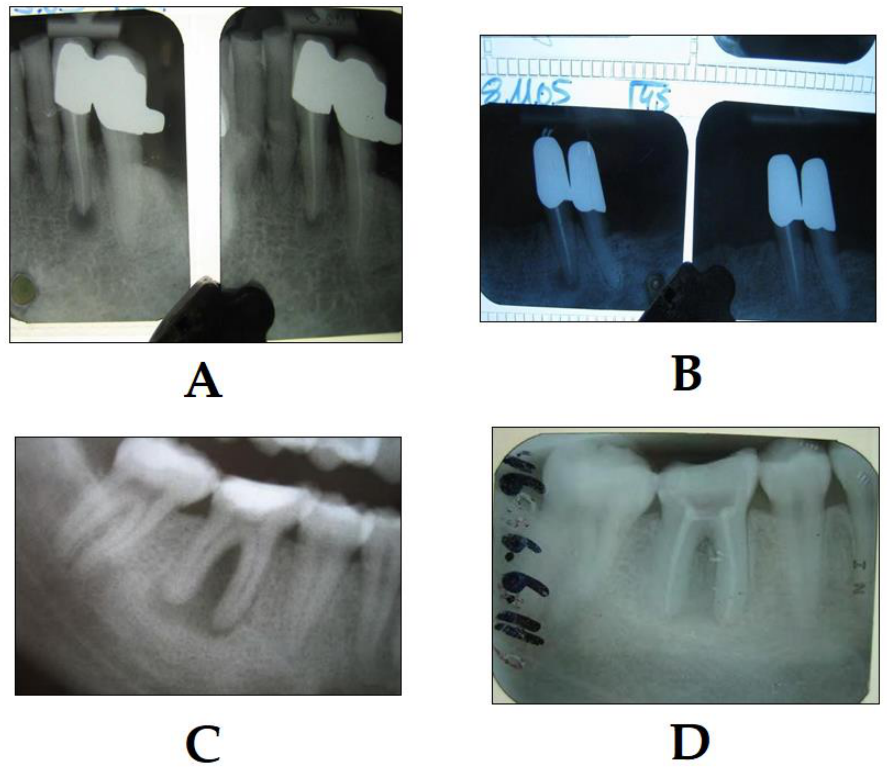
Figure 5. Success of PDT in the treatment of chronic periapical periodontitis (photo courtesy of R. Szabó DMD, J. Arentz DMD and T. Nave DMD). ( A ) The X-ray on the left shows the condition immediately after PDT, and the X-ray on the right shows the condition 4 months later; note the significant decrease in the size of the periapical lesion; ( B ) the X-ray on the left shows the condition immediately after PDT, and the X-ray on the right shows the condition 12 months later; note the significant decrease in the size of the periapical lesion. The same case is depicted in a lower molar tooth with chronic periodontitis, where ( C ) shows the condition immediately after the endodontic treatment and PDT, and ( D ) shows the condition after 3 months after the endodontic treatment, PDT therapy and root canal obturation; note the significant decrease in the size of the periapical